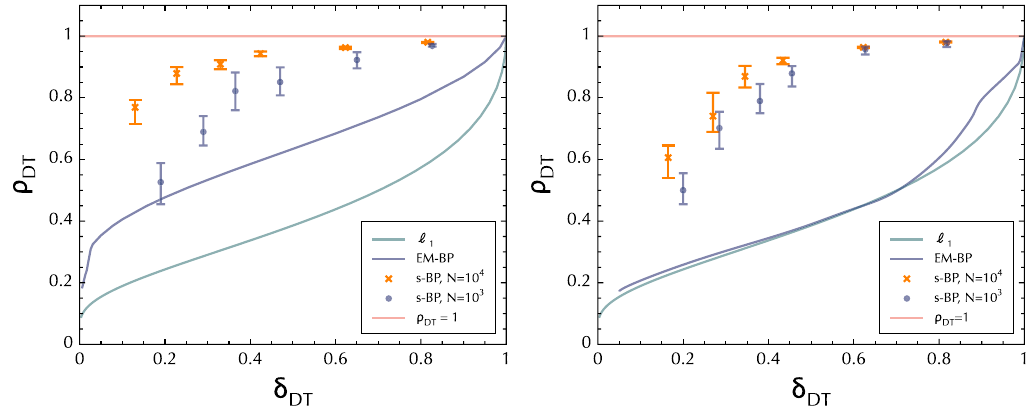
FIG. 7. Same data as in Fig. 2, but using the convention of [5]. The phase diagrams are now plotted as a function of the ¼ K=M ¼ (cid:2)=(cid:1) and of the oversampling ratio (cid:3) undersampling ratio (cid:2) DT